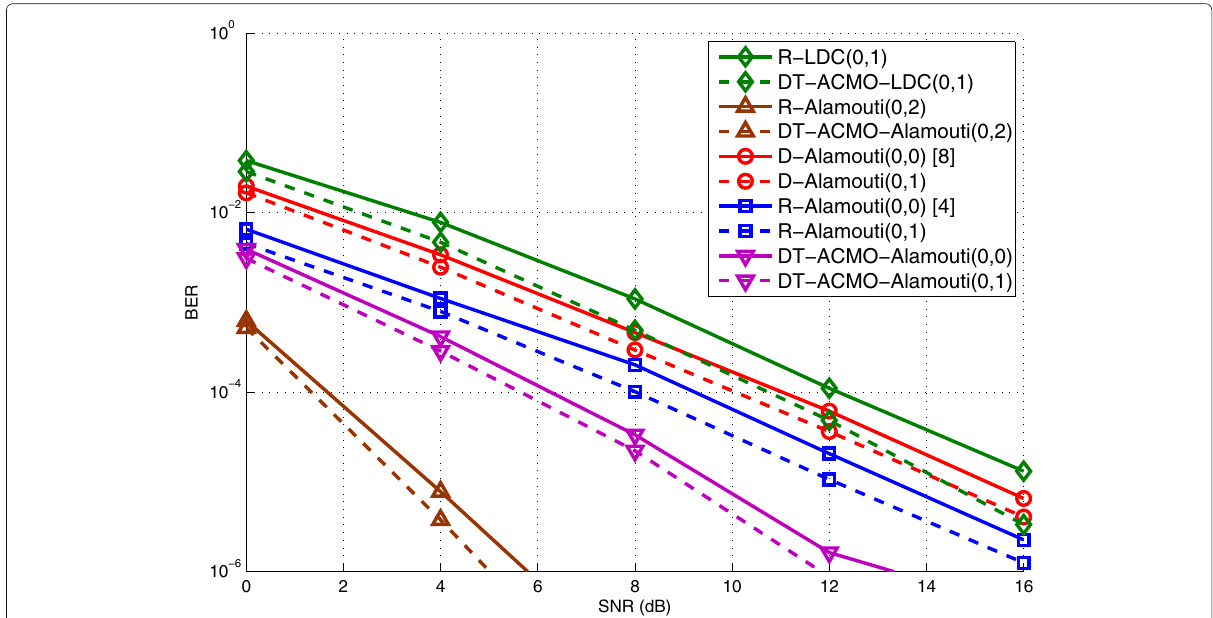
Fig. 4 BER performance vs. SNR for DT-ACMO RLS algorithm for